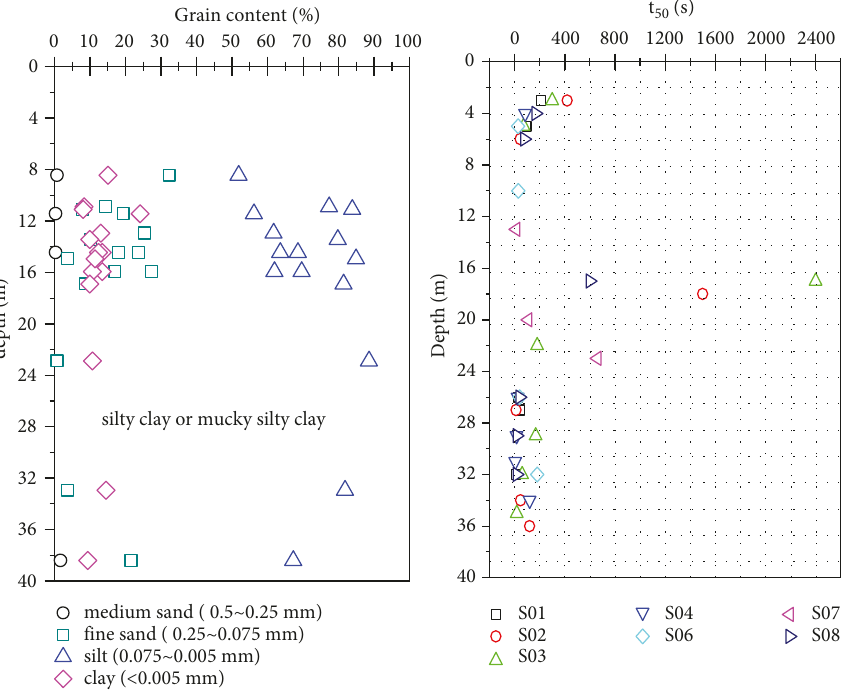
Figure 8: Grain content curve and t50 from pressure dissipation tests. Table 1: Summary of results from laboratory and CPTU evaluations of hydraulic conductivity ( k Soil